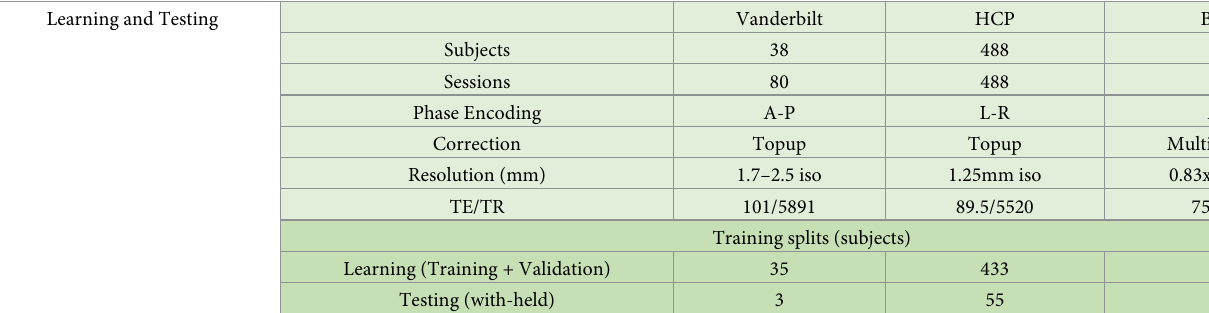
transforms were saved so the inverse transform could be applied to bring the results back into